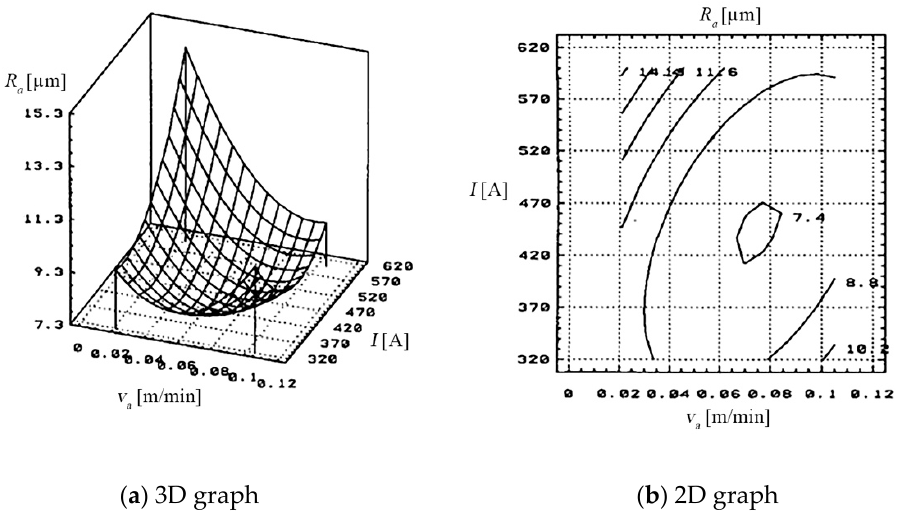
Figure 18. The dependency of the arithmetical mean deviation of the assessed profile ( R a ) to the feeding rate ( v a ) of the processing object and the working current ( I ): ( a ) 3D graph, ( b ) 2D graph. The optimal values of the rigidness R a = 9.5 [ µ m ] were obtained the following values of The dependency of the arithmetical mean deviation of the assessed profile ( R a ) to the metal band thickness ( s ) and the relative speed ( v r ) of the electrode-tool is presented in Figure 19.